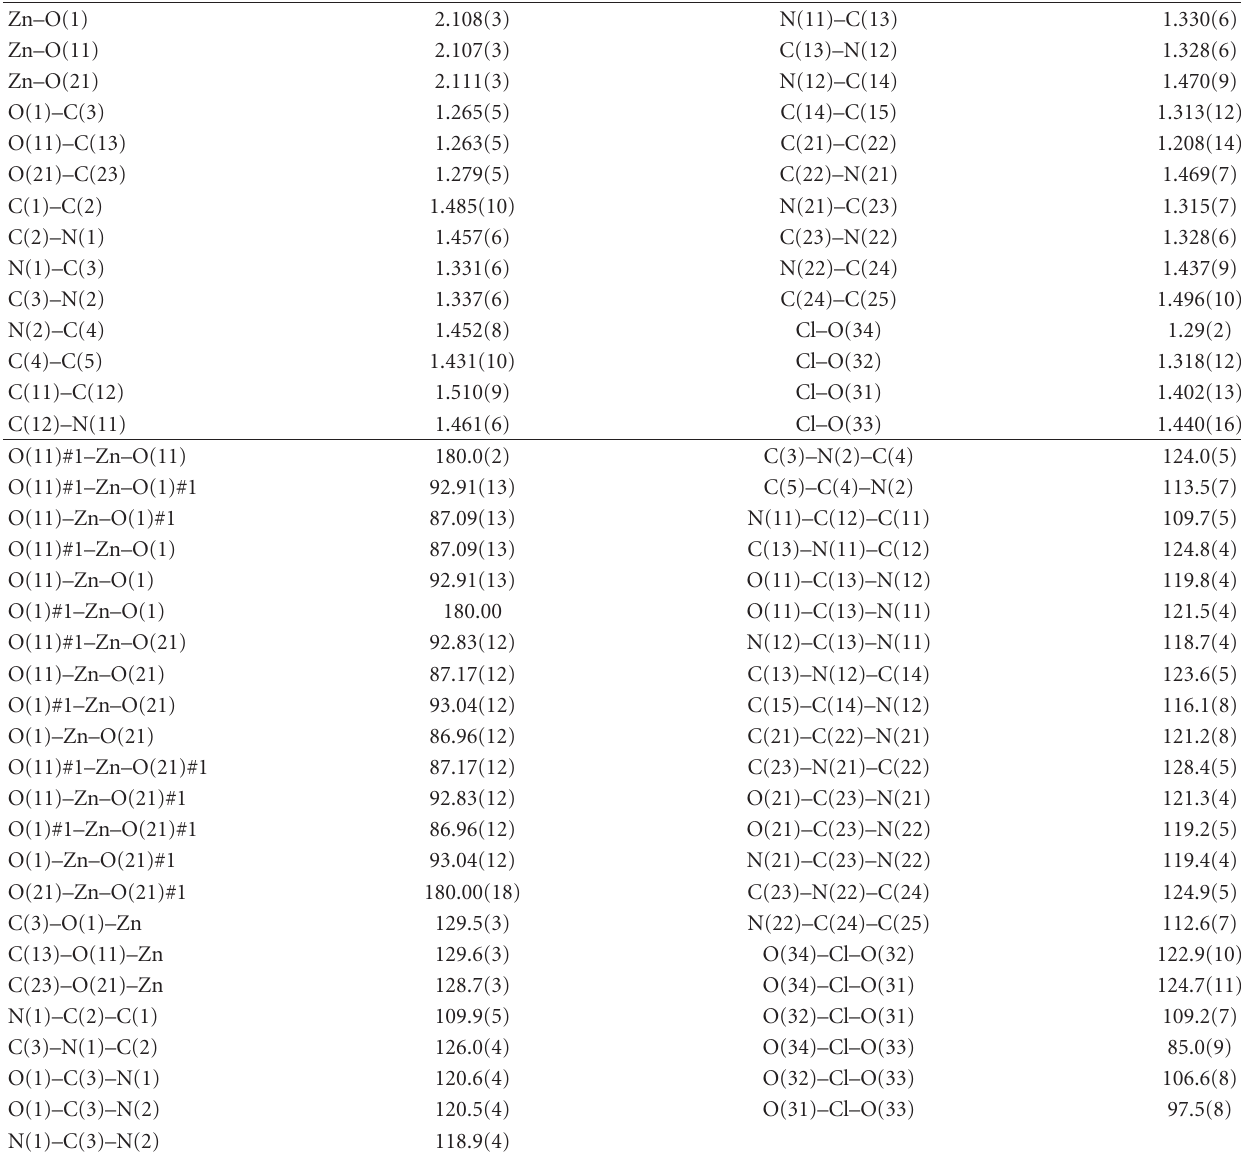
Table 5: Selected bond lengths (˚A) and angles ( ◦ ) for 4 .